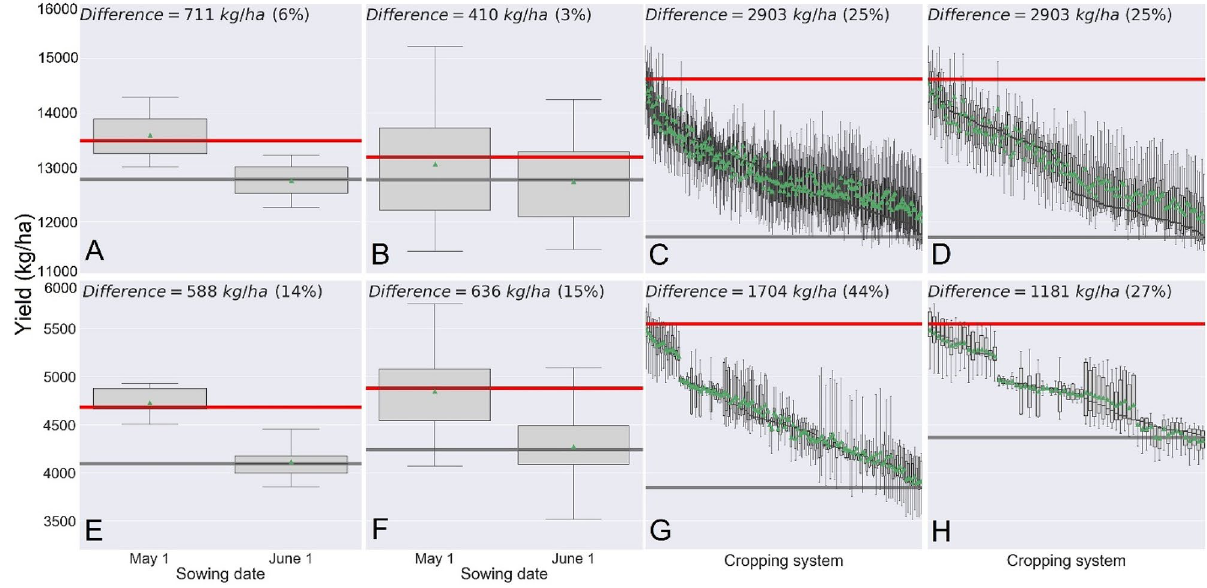
Figure 4. Maize yield difference (in kg/ha and percentage) due to sowing date (May 1st vs. June 1st) for a single identical background cropping system ( A ), maize yield difference due to sowing date when averaged across 256 (3 years × 256 cropping systems = 768 year-specific yields) ( B ), maize yield variability in each of the 256 cropping systems ( C ), and maize yield variability in each of the 128 cropping systems with early sowing ( D ). Soybean yield difference due to sowing date (May 1st vs June 1st) for a single identical background cropping system ( E ), soybean yield difference due to sowing date when averaged across 128 (5 years × 128 cropping systems = 640 year-specific yields) ( F ), soybean yield in each of the 128 cropping systems ( G ) and soybean yield variability due in each of the 64 cropping systems with early sowing ( H ). Within each panel, the horizontal red and grey lines indicate the boxplot with maximum and minimum yield, respectively. In the left four panels, boxes delimit first and third quartiles; solid lines inside boxes indicate median and green triangles indicate means. Upper and lower whiskers extend to maximum and minimum yields. Each maize and soybean cropping system is a respective 8-way and a 7-way interaction of management practices in a randomly chosen field in Wisconsin, USA (Table S3 and S5,